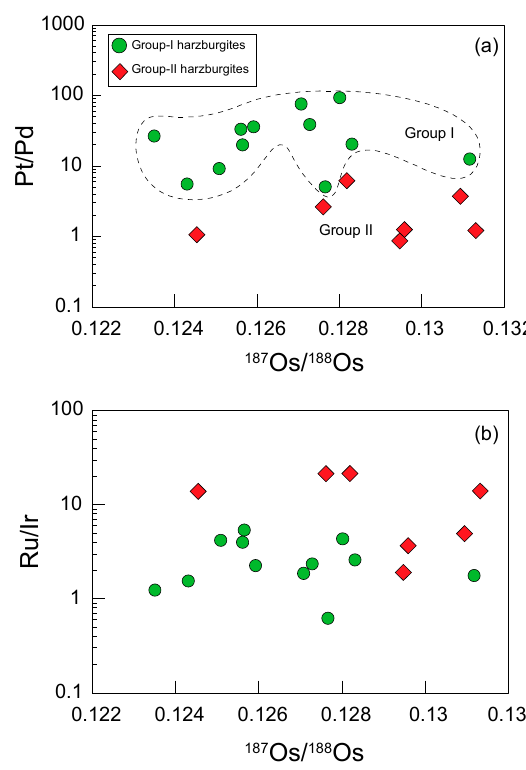
187 Os / 188 Os versus Pt / Pd ( a ) and Ru / Ir ( b ) in Me Maoya Figure 5. 187 Os/ 188 Os versus Pt/Pd ( a ) and Ru/Ir ( b ) in Me Maoya harzburgites. Figure 5.